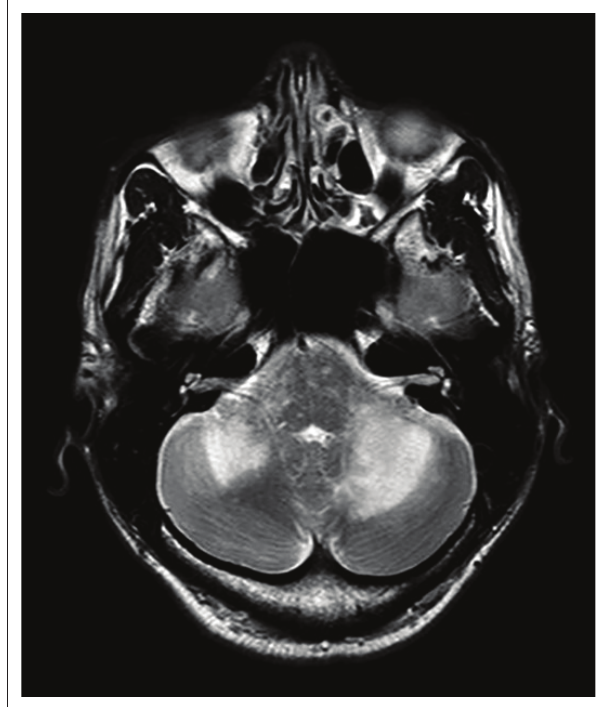
FIGURE 4: Axial T2 weighted image of the patient discussed in Case 4, at the level of the cerebellar pontine angles demonstrating confluent high-signal changes in both cerebellar hemispheres and patchy changes in the pons.